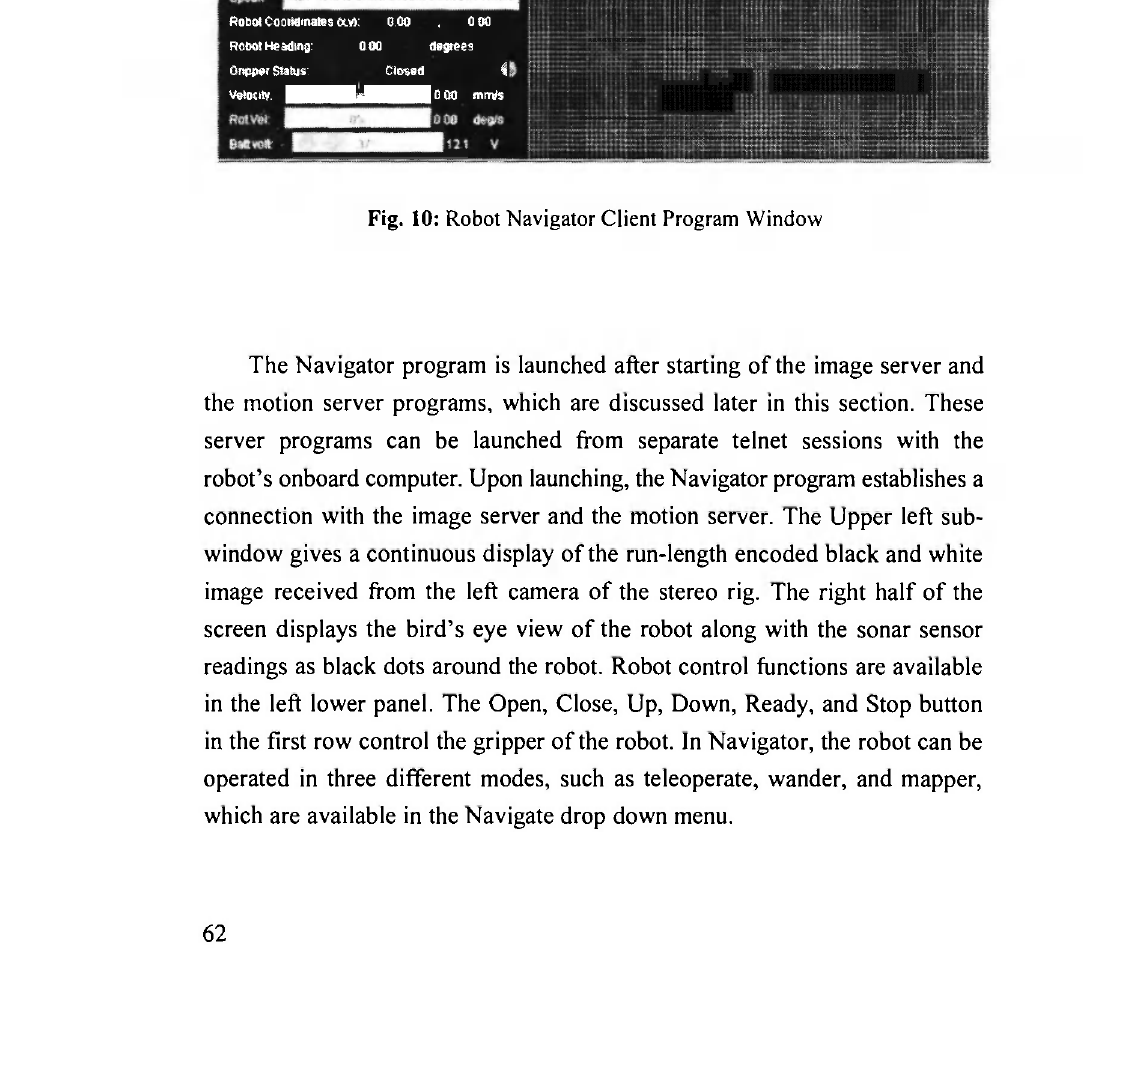
Fig. 10: Robot Navigator Client Program